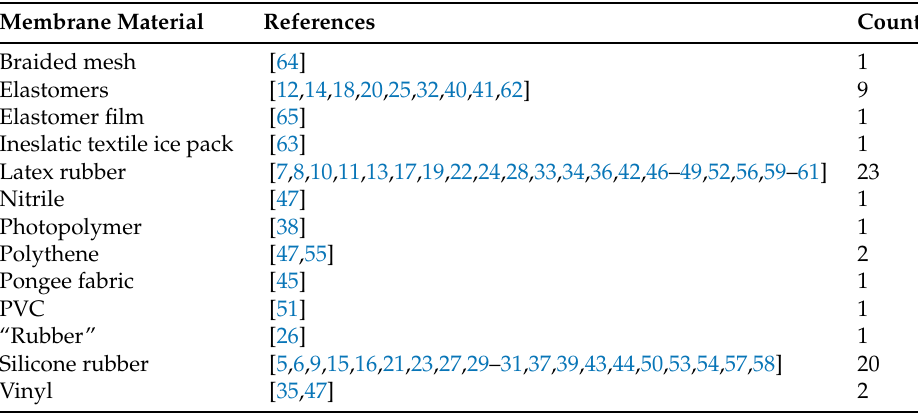
Table 5. Frequency of use of various membrane materials.